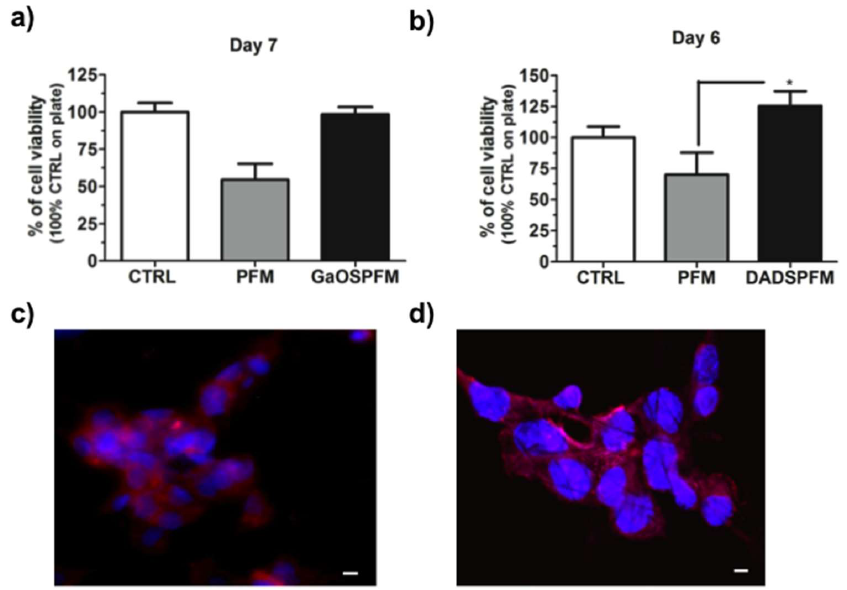
Figure 9. Biological properties of functionalized PFM. Cell viability of cMSC cultured on functionalized PFM: ( a ) on GaOSPFM and ( b ) on DADSPFM after 7 and 6 days of growth, respectively; ( c ) fluorescence micrograph of cMSC seeded on DADSPFM after 6 days and ( d ) confocal micrograph of cMSC seeded on DADSPFM after 7 days of culture. The nuclei are stained with Hoechst 33342 (in blue) and the phalloidin is in red. Scale bars = 10 μm. * p < 0.05 .